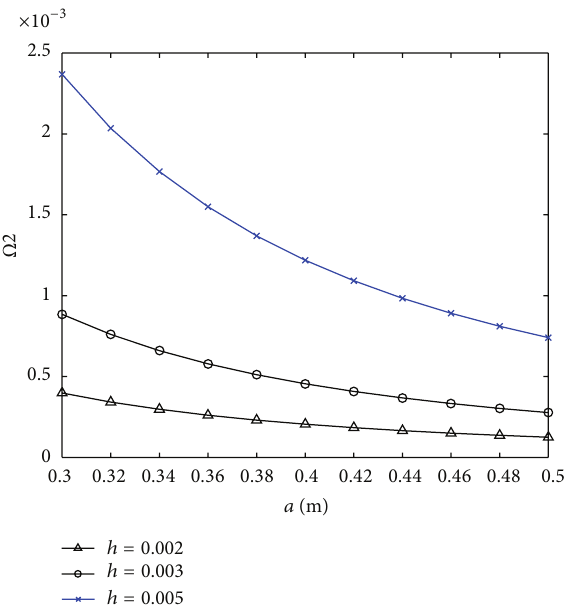
Figure 7: Variation of the second mode natural frequency with the radius of the plate for different composite layer thicknesses and clamped-clamped end conditions ( 𝑏 = 0.05 m).